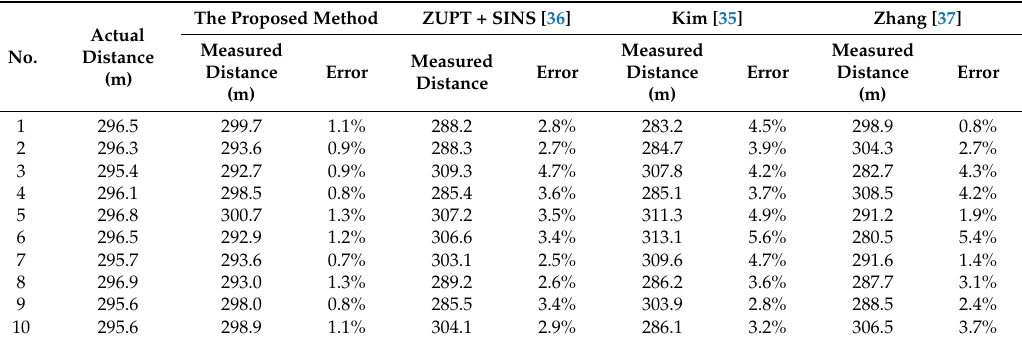
Figure 8. The reference trajectory. Table 3. Experimental results for the walking experiment with complex